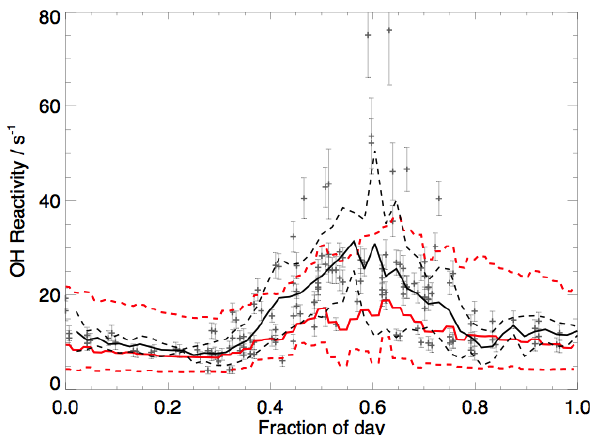
Figure 11: OH reactivity observations (black markers) plotted as a diurnal, with error bars indicating +/- 1 sigma uncertainty on each observation. The solid black line is the mean diurnal profile, averaged into 30 min time bins, with the dashed black lines indicating +/- 1 standard deviation within that 30 min bin. The solid red line shows the modelled OH reactivity using the mean diurnal concentrations of the measured isoprene, OH and monoterpenes, the other measured species shown in Fig. 6 constrained to their mean value, and also using the steady state concentrations of the oxidation products of these constraining species, calculated by the MCM v3.2 chemistry scheme. The dashed red lines are the modelled OH reactivities constraining to +/- 1 standard deviation of the observed OH and isoprene concentrations, with all other constraining species kept at the same concentrations as the solid red line simulation.